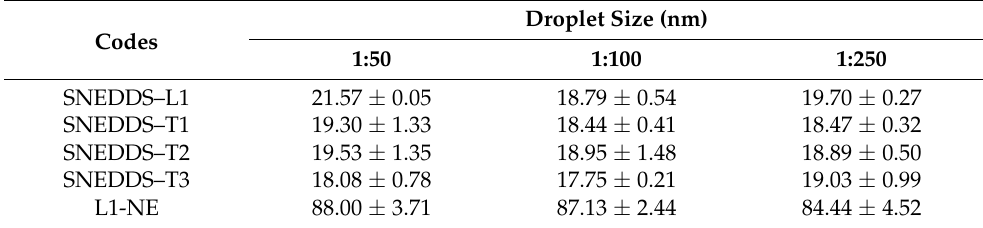
Table 3. Robustness to dilution studies of ASX-loaded SNEDDS (mean ± SD; n = 3).